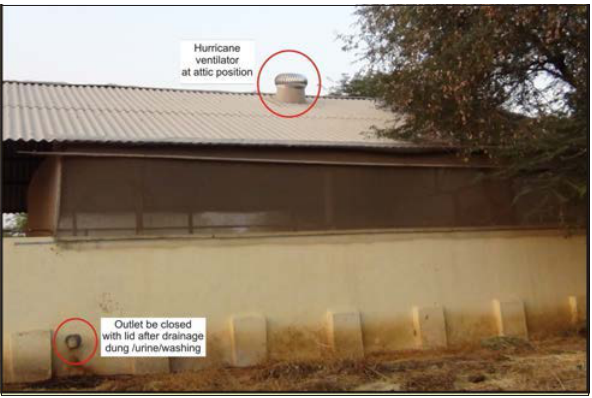
Figure-2: Side view of gable type fly proof net